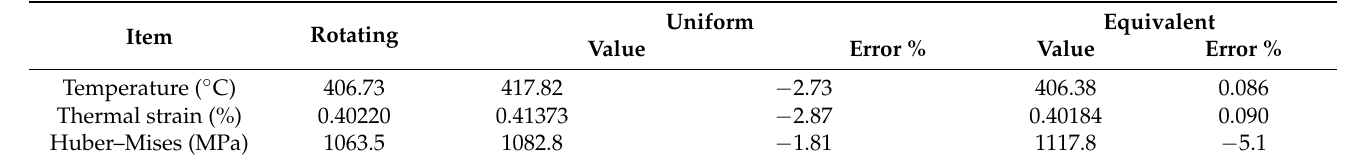
Table 5. Comparison of the results among uniform, rotating and equivalent